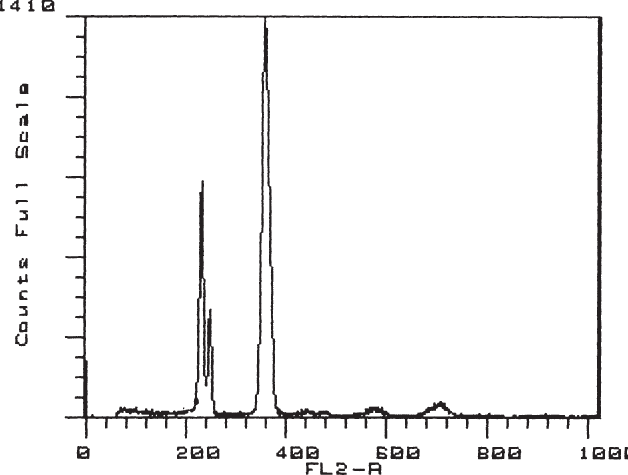
Fig. 3. Detection of a DNA near-diploid peak with DI = 1.07 and a DNA near-triploid peak with DI = 1.56. CV of G0–G1 DNA diploid peak (left) was